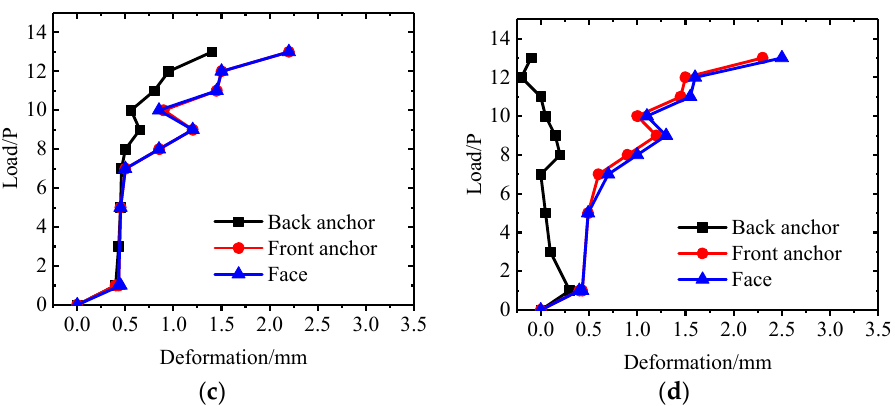
Figure 10. Overload and failure deformation test results of sliding micrometer for surrounding rock outside anchorage tunnel: ( a ) H1; ( b ) H4; ( c ) H2; ( d ) H3.